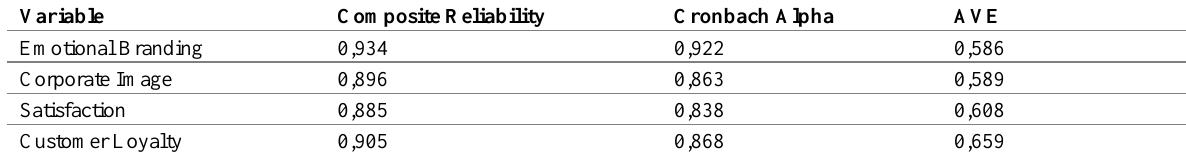
Table 1: Composite Reliability, Cronbach Alpha, AVE